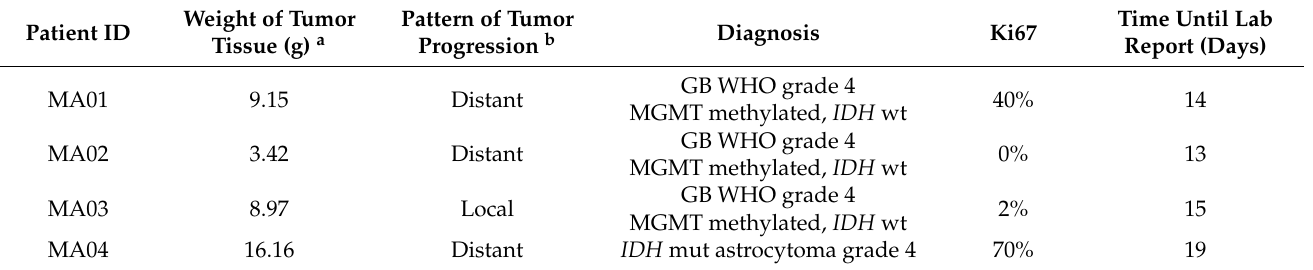
Figure 1. MRI characteristics of the patients included in this study. MRIs show contrast-enhanced, suspected recurrent high-grade glioma prior to re-resection. Outlined in blue is the resection cavity after the second surgical treatment with partial or complete resection of the contrast-enhanced tumor. In the MRI of patient MA02, the resection cavity from initial surgery is marked with a red arrowhead; in this case, the plane of the resection cavity is within the same axial plane as the recurrent contrast enhancement. Table 1. Tumor characteristics.